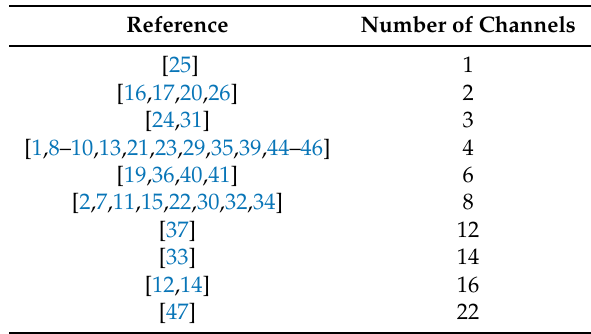
Table 3. Reported number of channels.